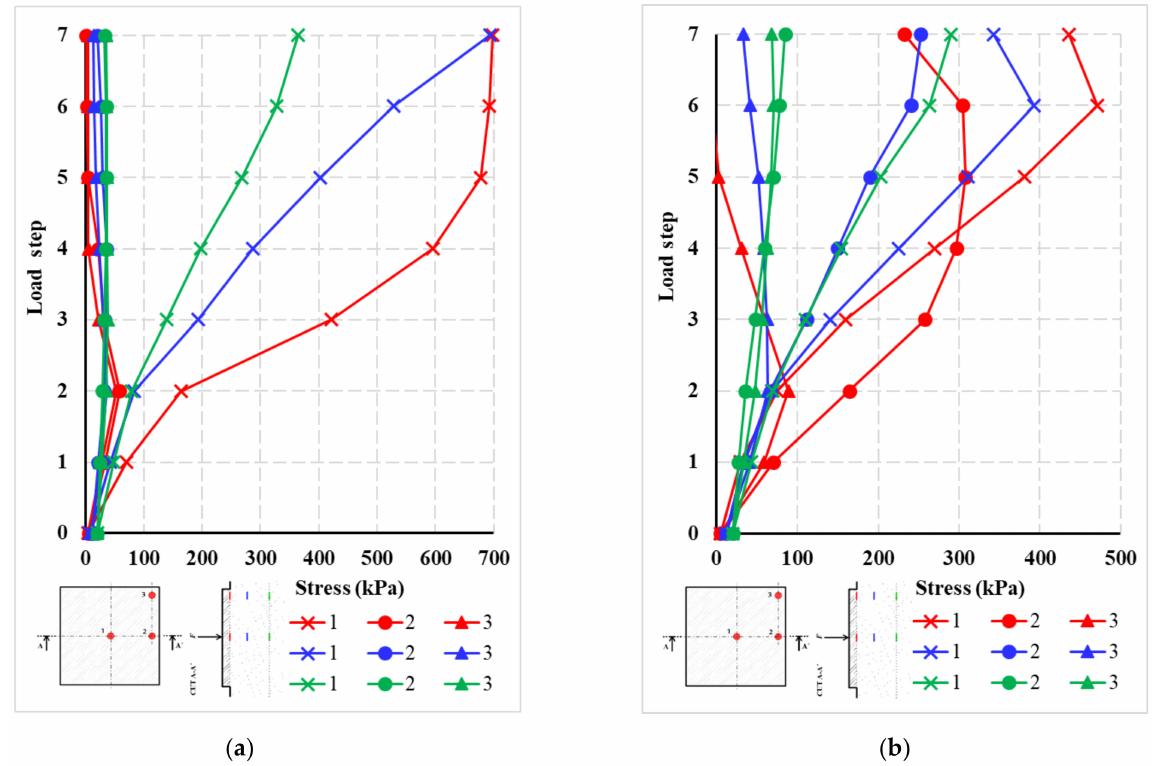
Figure 25. Stress in individual pressure cells: ( a ) centrically loaded slab G10; ( b ) eccentrically loaded slab G11.